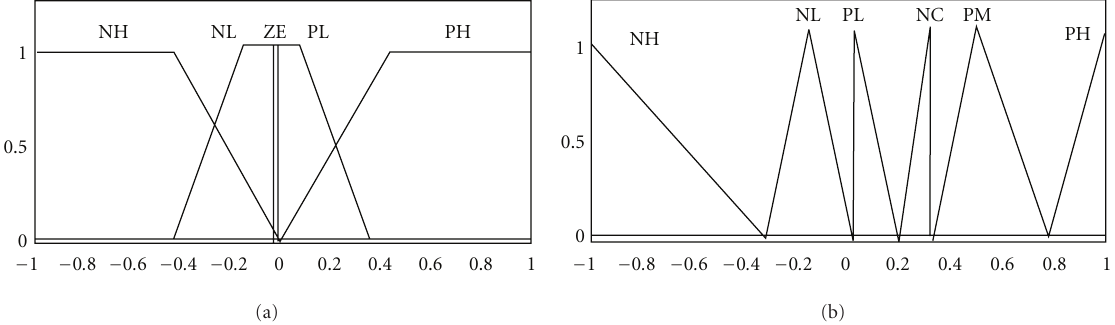
Figure 3: Member functions for (a) speed error Δ ω rn and (b) command torque T ∗ e .